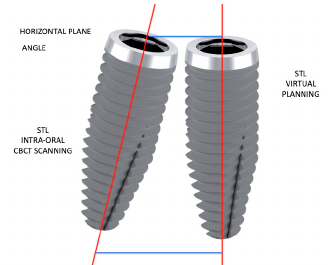
Figure 2. The 3D STL intra-oral cone-beam analysis (CBCT) scanning position data as compared to the STL virtual planning data in millimetric horizontal and spatial angle evaluation. Software reconstruction of dental implant virtual planning vs clinical position after the surgical procedure.